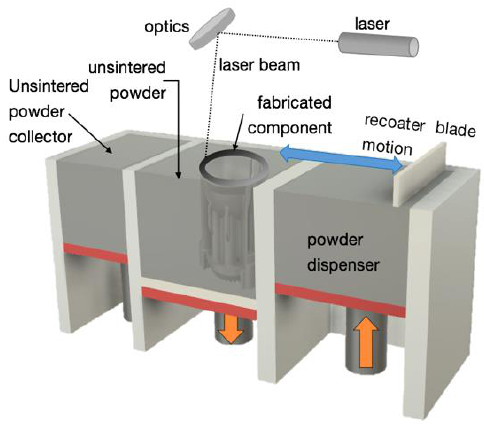
Figure 1. Conceptual schematic of powder bed laser Additive Manufacturing.